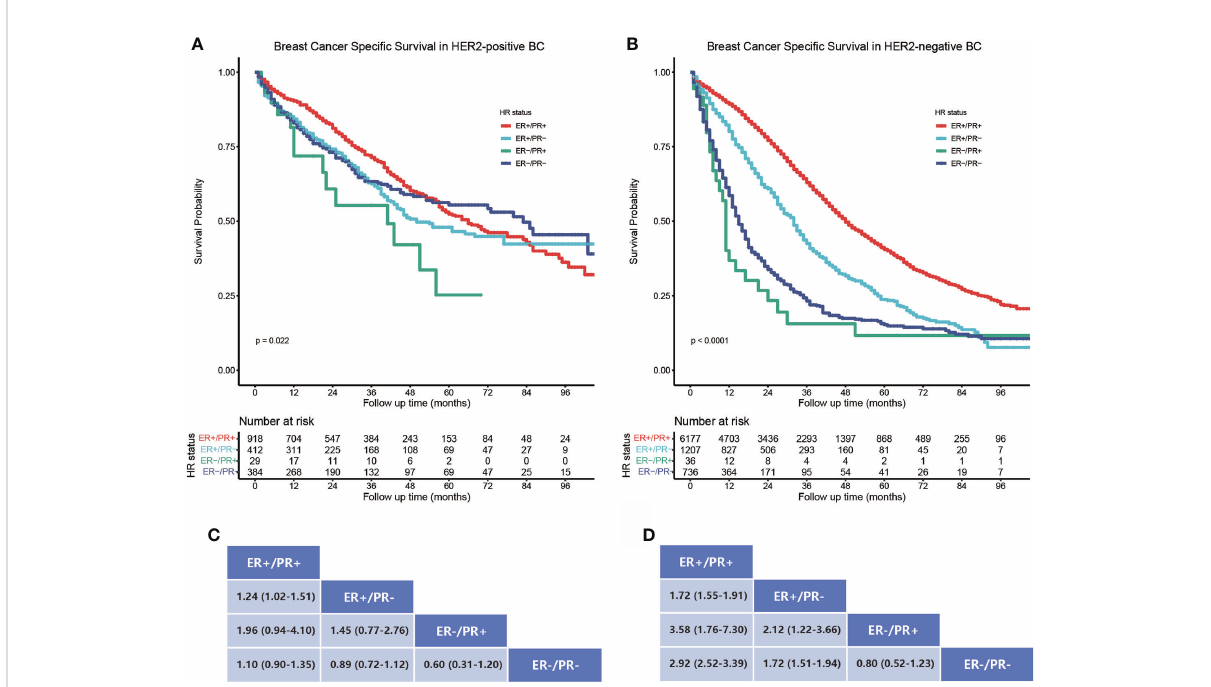
FIGURE 3 Subgroup BCSS analysis in HER2-positive and negative bone metastatic breast cancers strati fi ed by HR status. (A) Kaplan – Meier survival curves show the BCSS rate difference in HER2-positive bone metastatic breast cancers strati fi ed by HR status. (B) Kaplan – Meier survival curves show the BCSS rate difference in HER2-negative bone metastatic breast cancers strati fi ed by HR status. (C, D) Data are presented as hazard ratios (95% CIs) between HR status subgroups regarding BCSS in HER2-positive and negative bone metastatic breast cancers. A hazard ratio exceeding 1 favors the column-labeled HR status